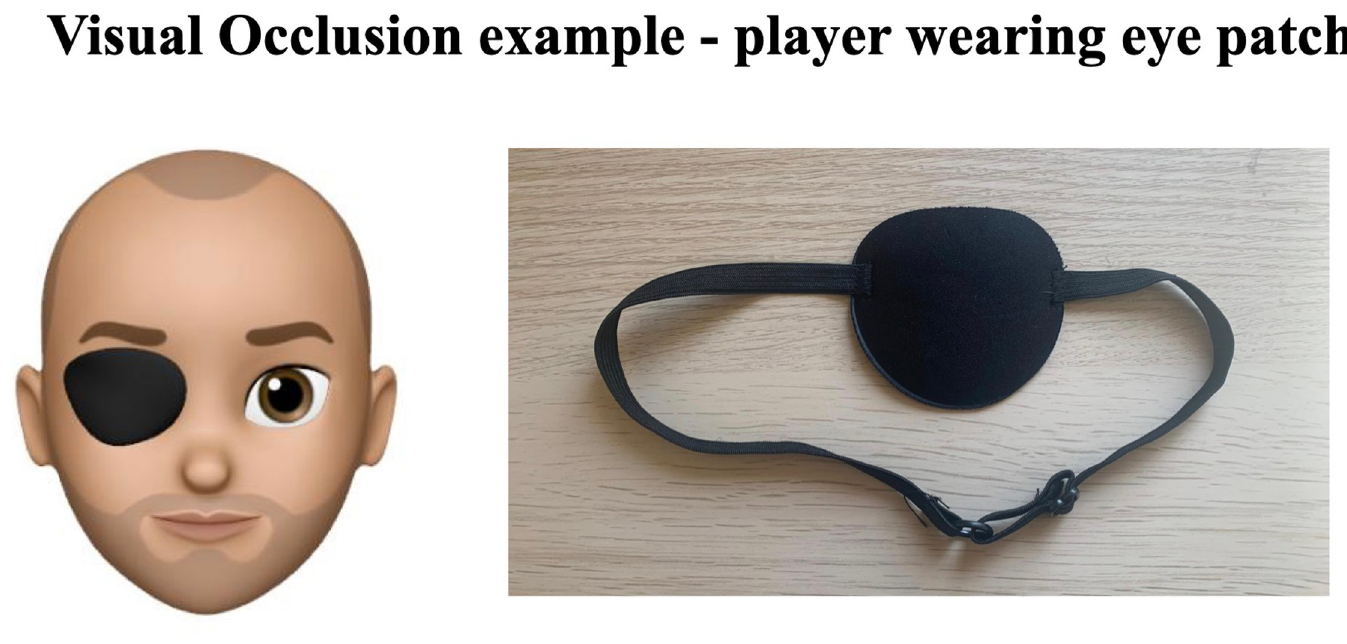
Fig 1. Representation of a player wearing the eye patch during the